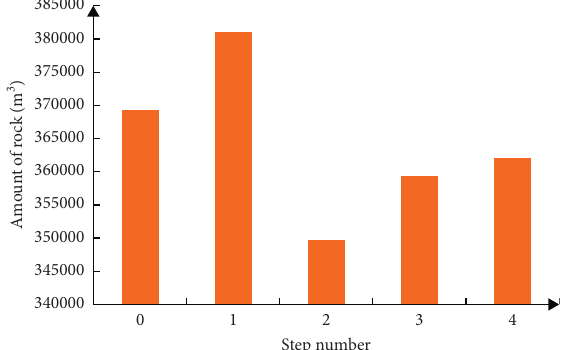
Figure 8: Amount of rocks in each step.